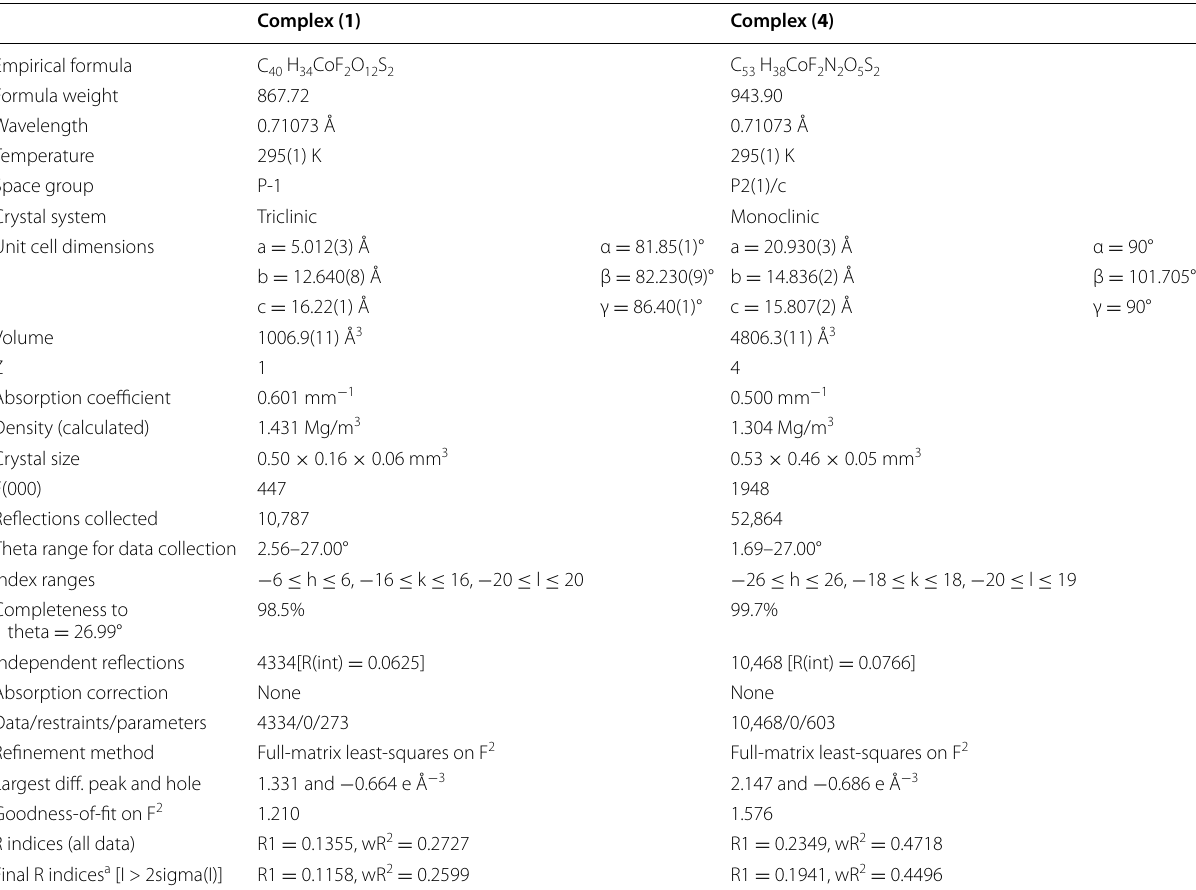
Table 6 Structure refinement of crystal data for compounds (1) and